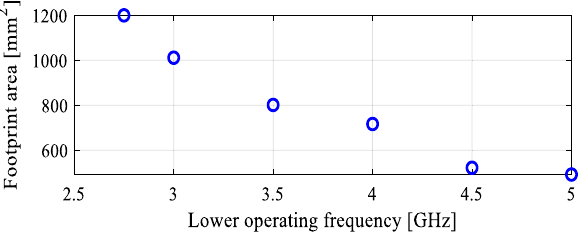
Figure 13. Trade-off designs for the CP antenna of Fig. 10. minimum attainable footprint area versus the lower end of the operating bandwidth (minimum value of the upper end equals 7.5 GHz for all cases).